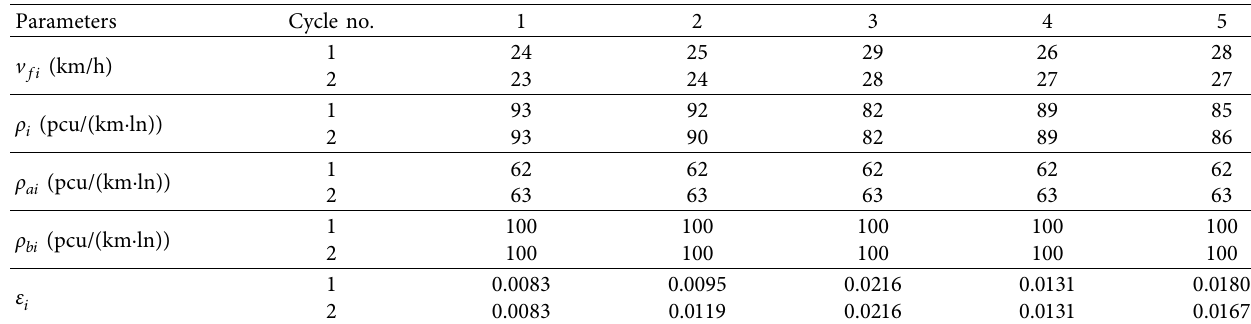
Table 5: Various parameter values of the lane-changing areas of the target